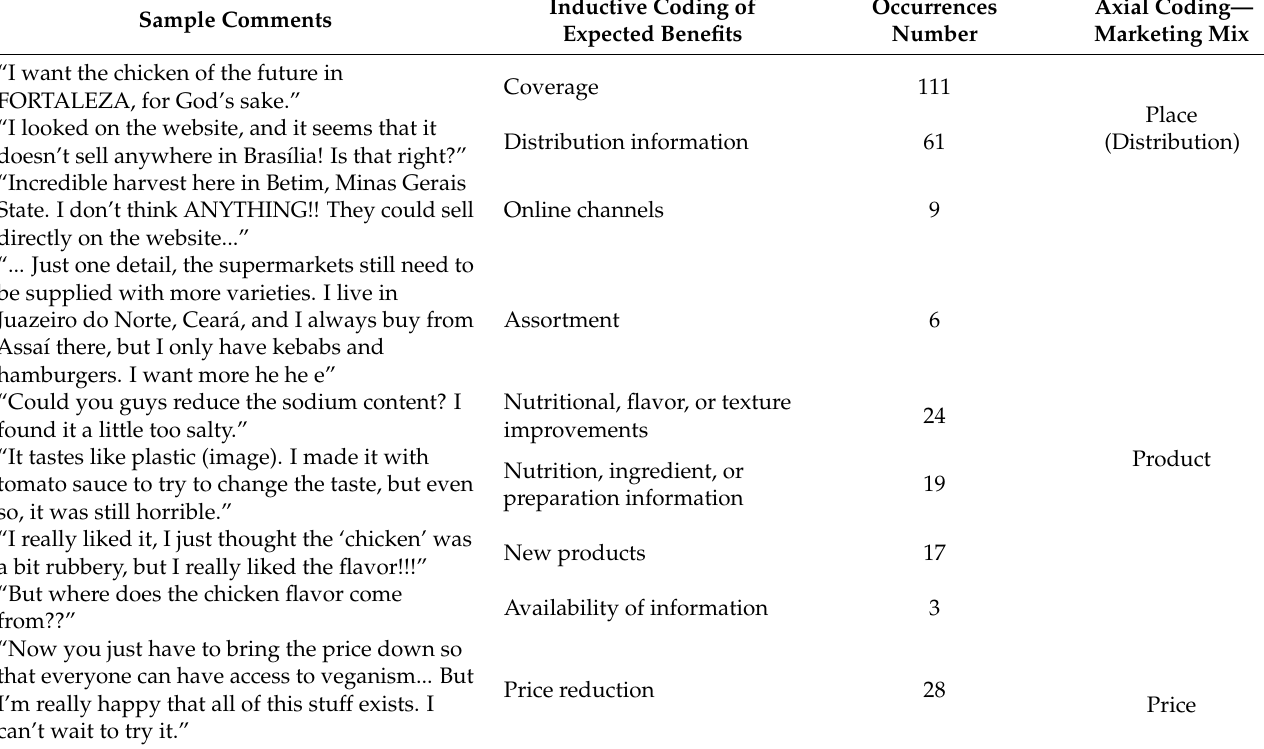
Table 2. Content analysis